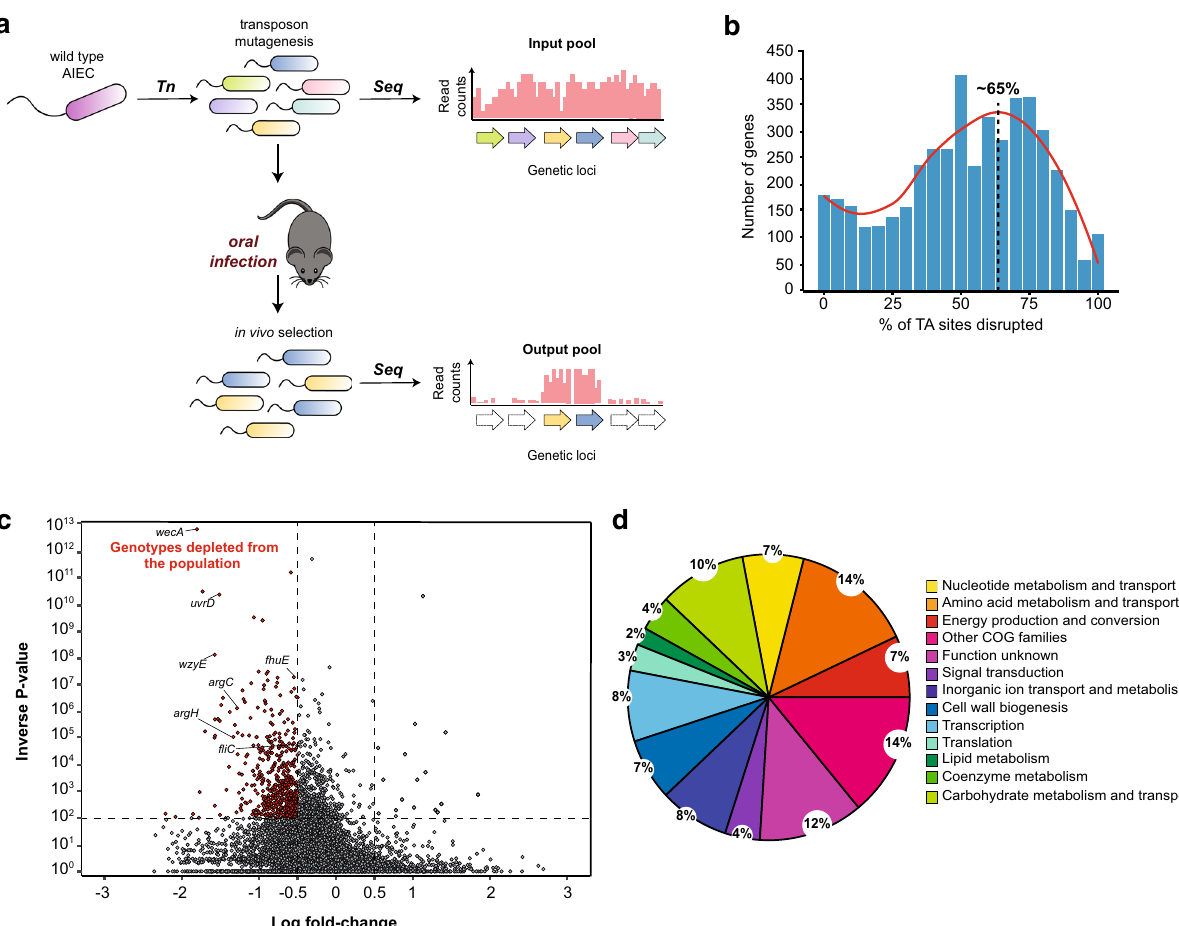
Fig. 1 Identi fi cation of the genetic requirements for AIEC fi tness in the gut. a Experimental scheme for the transposon (Tn) sequencing (Seq)-based screen for AIEC colonization determinants in the host environment. b Histogram showing the percentage of TA sites disrupted per gene in AIEC str. NRG857c input library using the modi fi ed transposon system. c Volcano plot showing the mean fold change in genotype abundance of three genomic libraries versus the statistical signi fi cance (inverse P value); n = 3 biologically independent animals infected with the mutant libraries. Computation of P values is constitutive of the ConARTIST analysis pipeline using Mann – Whitney U test. Red dots represent the genotypes with signi fi cant variation in abundance in vivo ( P value <0.01 in all three biological replicates). d Functional assignment of the AIEC in vivo-depleted loci to COG